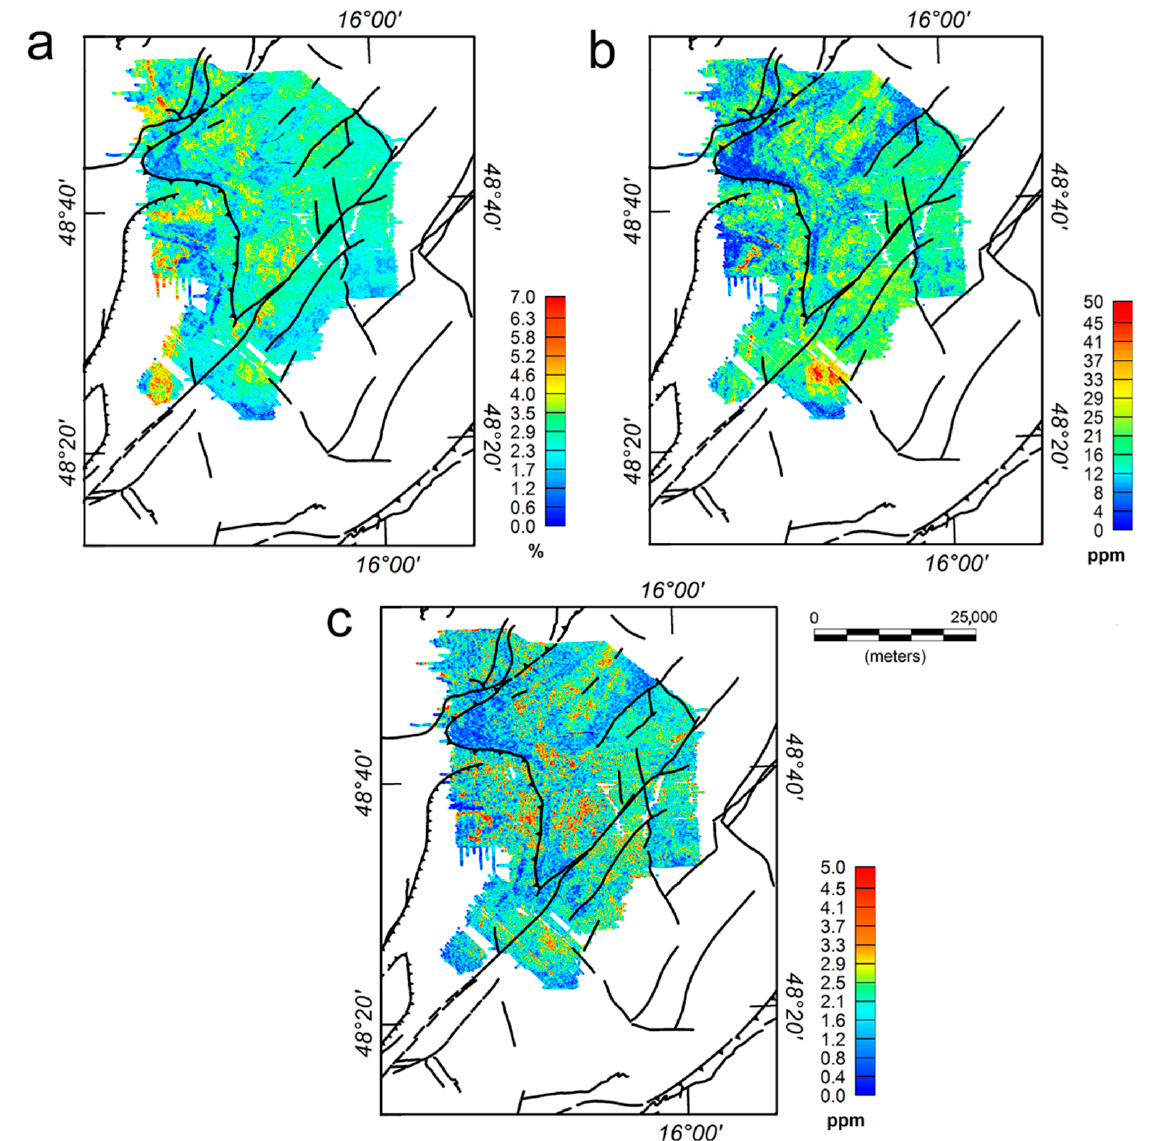
Figure 6. ( a ) Aero-radiometric potassium data (K); ( b ) Aero-radiometric thorium data (Th); ( c ) Aero- radiometric uranium data (U). The main maxima in the three maps are well-correlated with the known faults and geological units of the survey area.